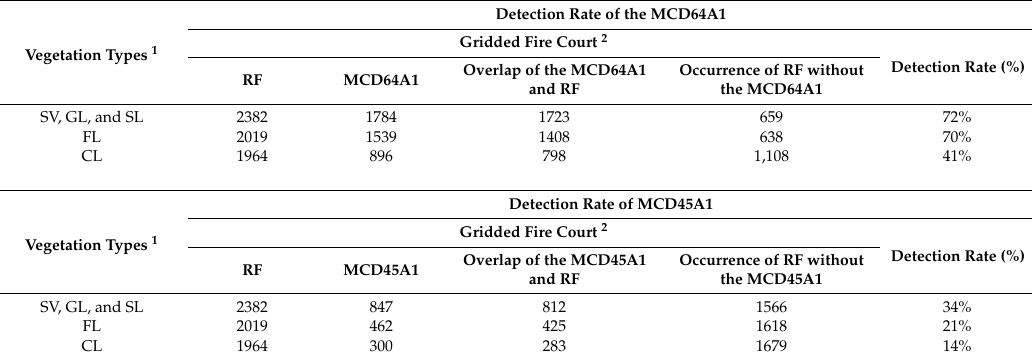
Table 4. Detection rate of the gridded fire court overlap between the MCD64A1 and MCD45A1 and the reference fires.